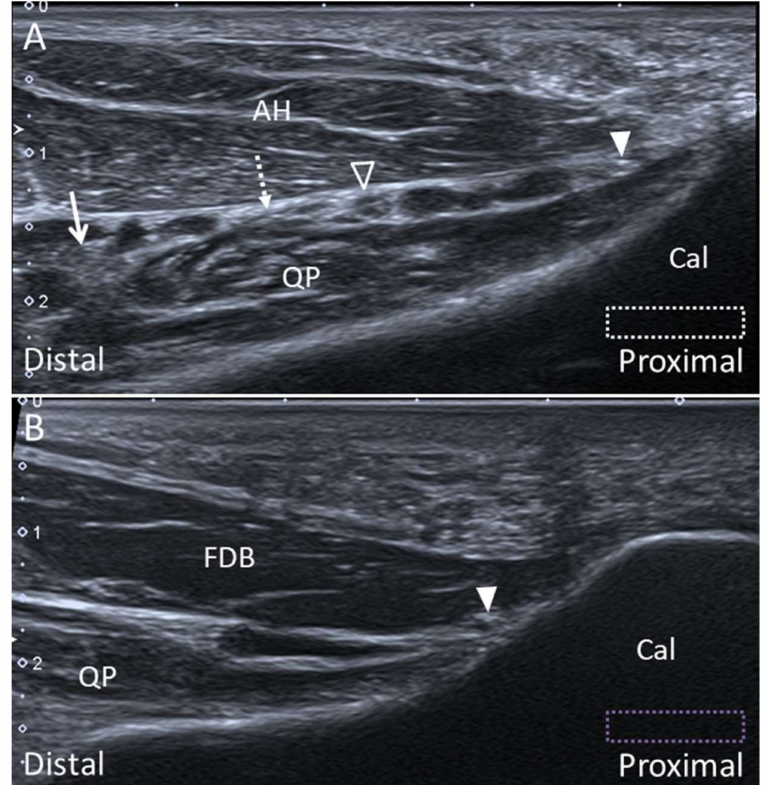
Figure 26. Ultrasound imaging of the Baxter nerve (arrowheads) between the abductor hallucis (AH) and the quadratus plantae (QP) muscles ( A ) and between the flexor digitorum brevis (FDB) and QP muscles ( B ). The colored dashed rectangles are in accordance with the transducer positions in Figure 3A,B. Lateral plantar nerve: void arrowhead; medial plantar nerve: arrow; medial septum: dotted arrow. Cal,